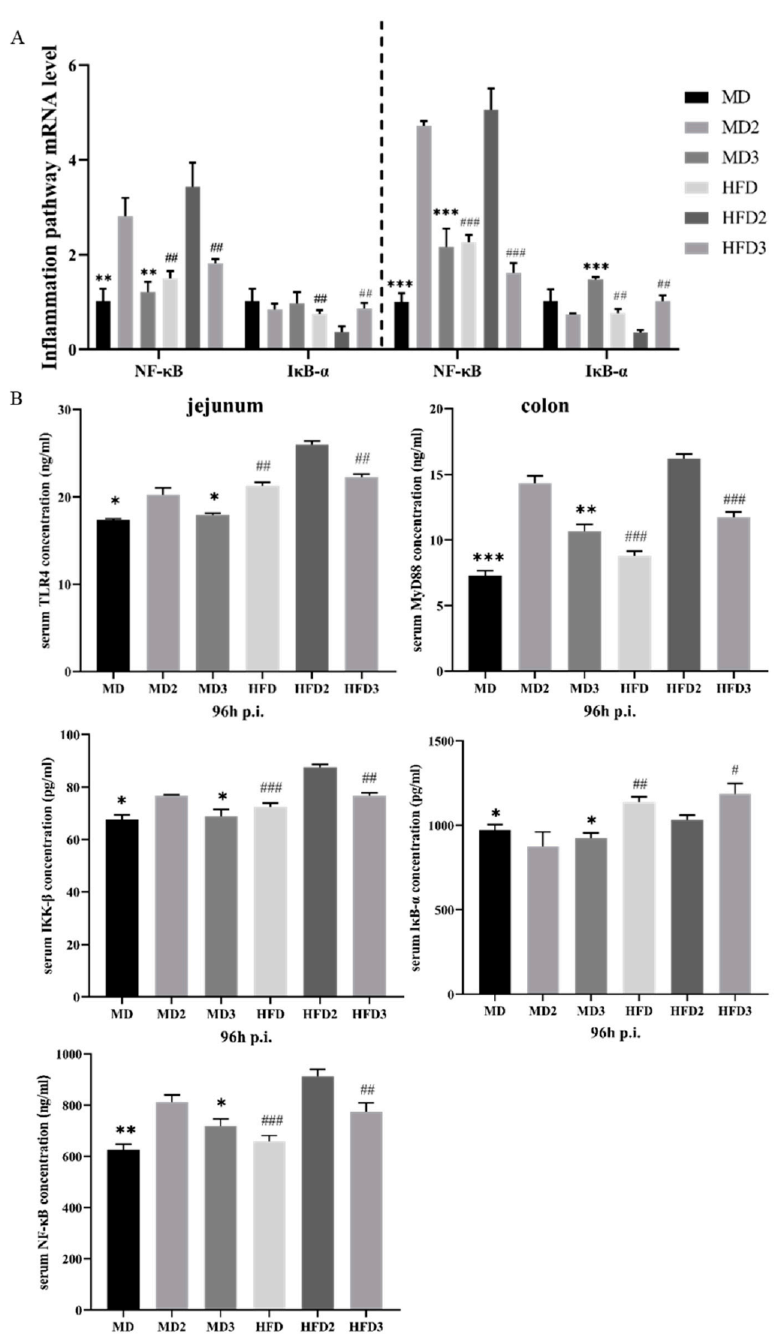
Figure 3. L. plantarum 1201 relieves intestinal inflammation through the TLR4/NF- κ B inflammatory pathway. ( A ) mRNA expression of NF-kB inflammation pathway in colon and jejunum of mice in different groups; ( B ) concentration of TLR4/NF- κ B pathway protein in mouse serum. * p < 0.05; ** p < 0.01; *** p < 0.001; # p < 0.05; ## p < 0.01; ### p < 0.001; * is compared with MD2, # is compared with HFD2; paired two-tailed t-test. MD: normal diet; MD2: normal diet and 1 × 10 8 CFU/mL S. Typhimurium ATCC 13311; MD3: normal diet, 1 × 10 8 CFU/mL S. Typhimurium ATCC 13311 and 1 × 10 8 CFU/mL L. plantarum 1201; HFD: HFD; HFD2: HFD and 1 × 10 8 CFU/mL S. Typhimurium ATCC 13311; HFD3: HFD, 1 × 10 8 CFU/mL S. Typhimurium ATCC 13311 and 1 × 10 8 CFU/mL L. plantarum 1201; p.i., post